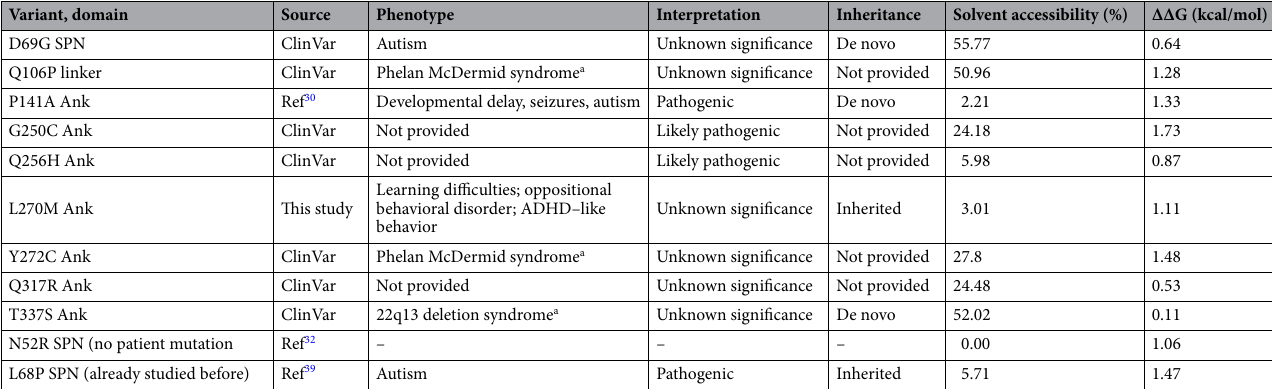
Table 1. Overview of SHANK3 variants analysed in this study. Solvent accessibility of the residue at this position and free energy changes (ΔΔG values), indicating altered stability, are calculated using PoPMuSiC software. Note that the original publication for the ΔΔG calculation lists a maximum value of ± 4 kcal/mol for destabilising/stabilising variants 28 . a several entries in ClinVar are listed as “Phelan-McDermid syndrome” or under the alternative name “22q13 deletion syndrome”, though there is no deletion involved but a missense mutation, as